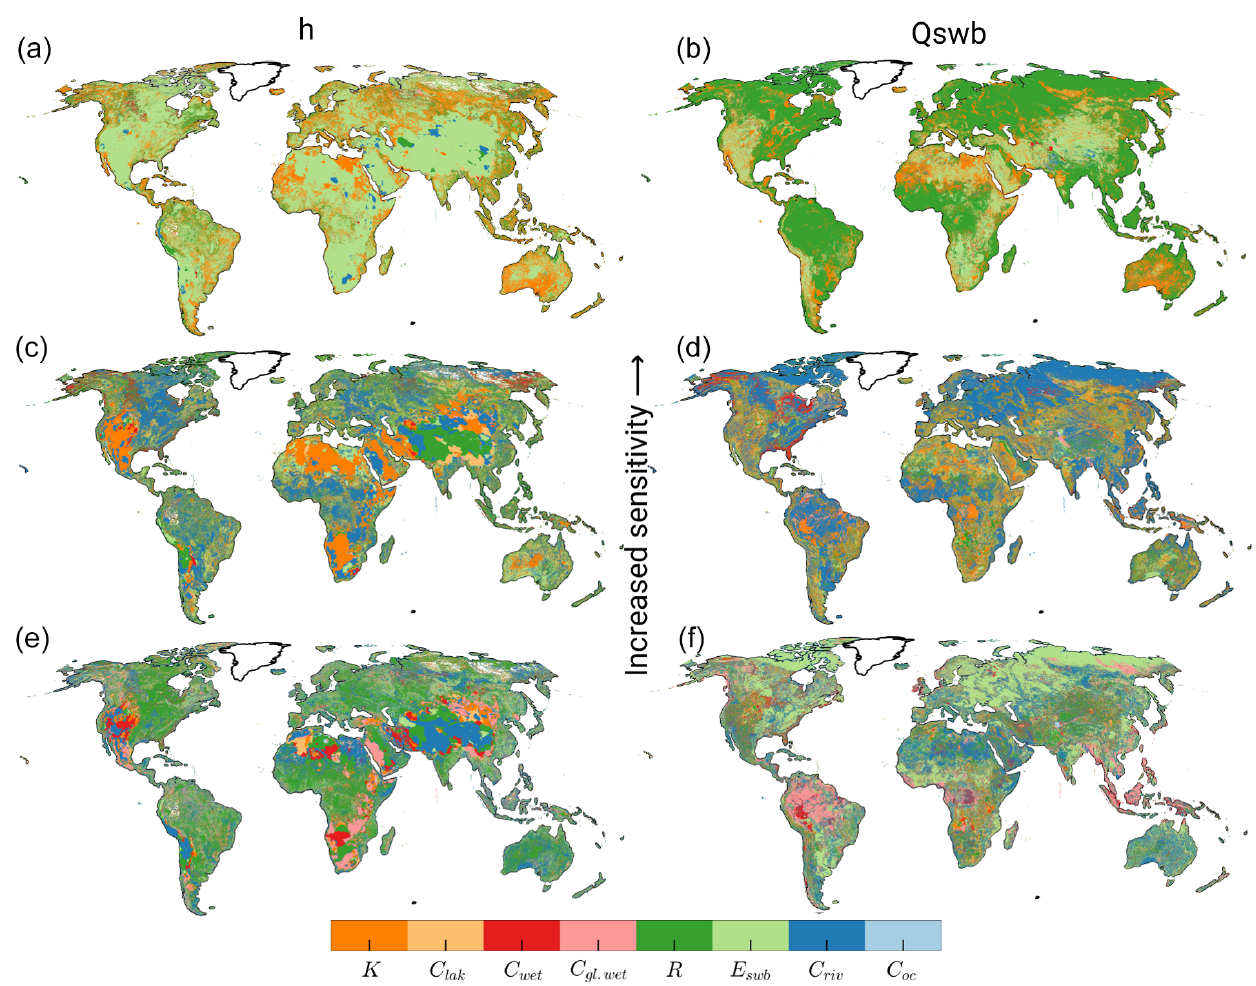
Figure 7. Ranking of µ ∗ of h (a, c, e) and Q swb (b, d, f) . Panels (a, b) show the first rank, (c, d) the second, and (e, f) the third